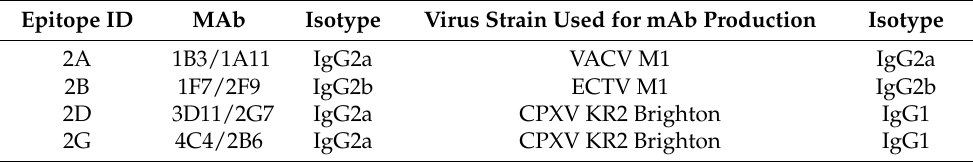
Table 1. Monoclonal antibodies (mAb) [35] used in an inhibition ELISA for the identification of the target of scFv